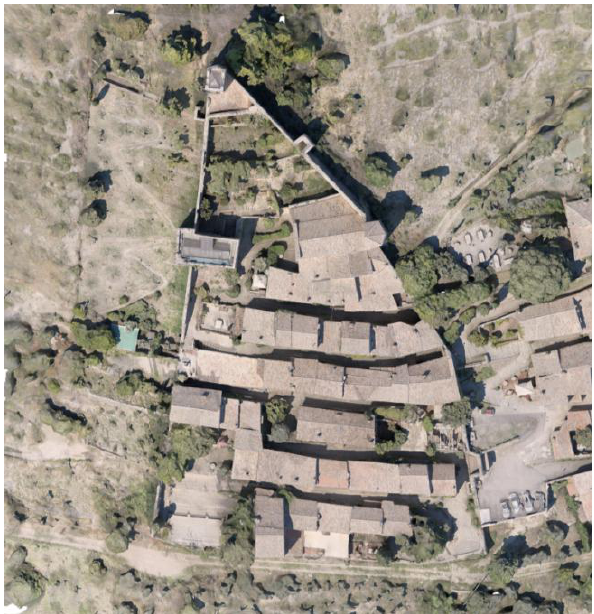
Figure 3. HD orthophoto obtained through